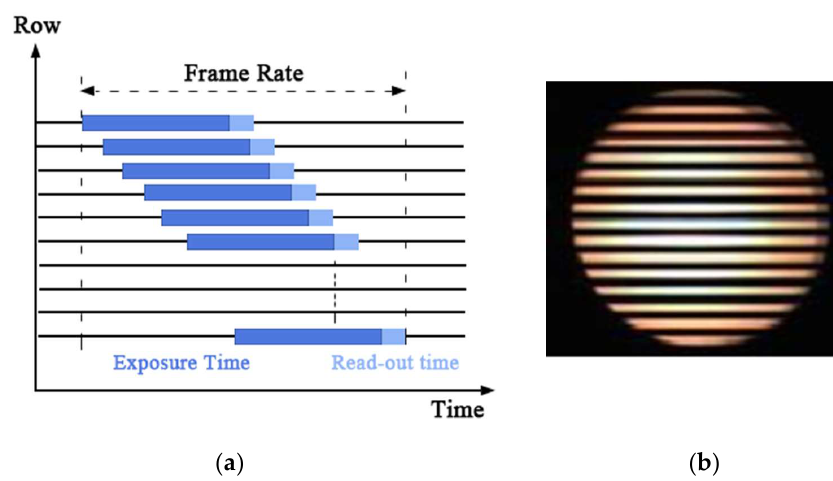
Figure 2. ( a ) The rolling shutter mechanism of the CMOS. ( b ) The target signal source LED area of the captured image of the CMOS sensor after a period of exposure.